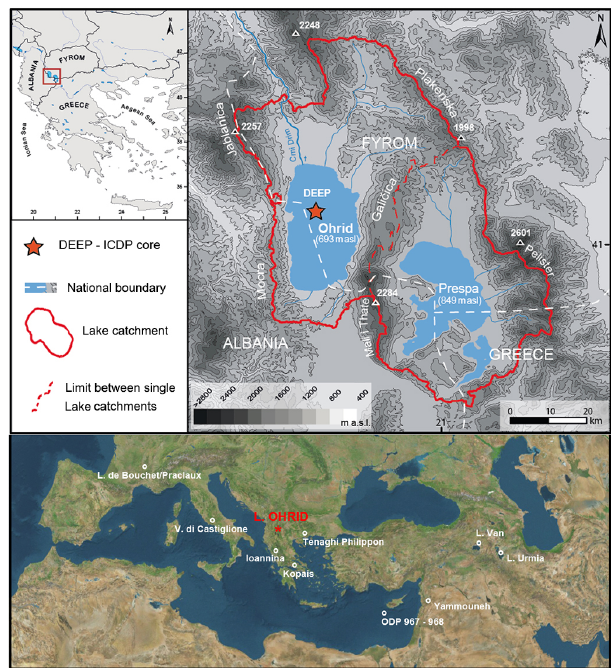
Figure 1. Map of Lake Ohrid modified from Panagiotopoulos (2013) and locations of terrestrial and marine records discussed in the